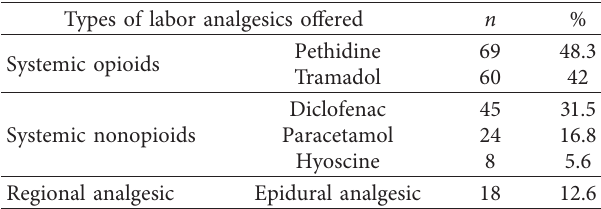
Table 2: Types of labor analgesia offered by obstetric care providers in public hospitals of Addis Ababa, Ethiopia, 2020 ( n �